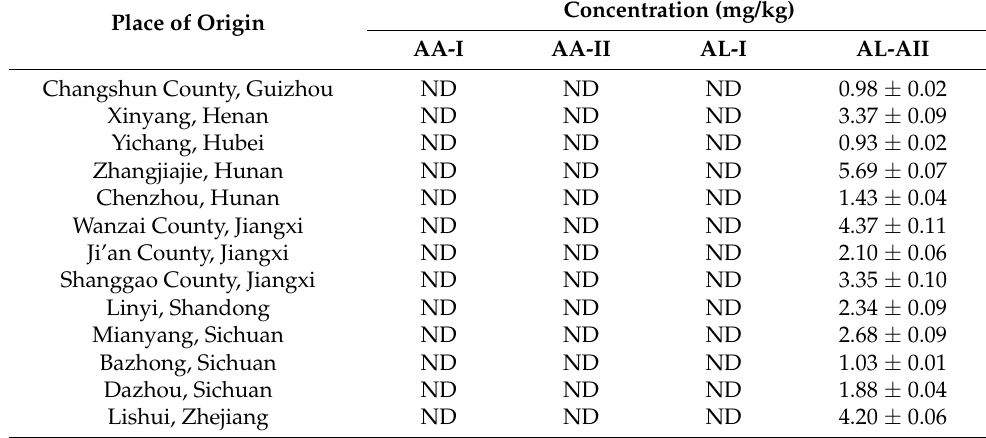
Table 5. Cont. Place of